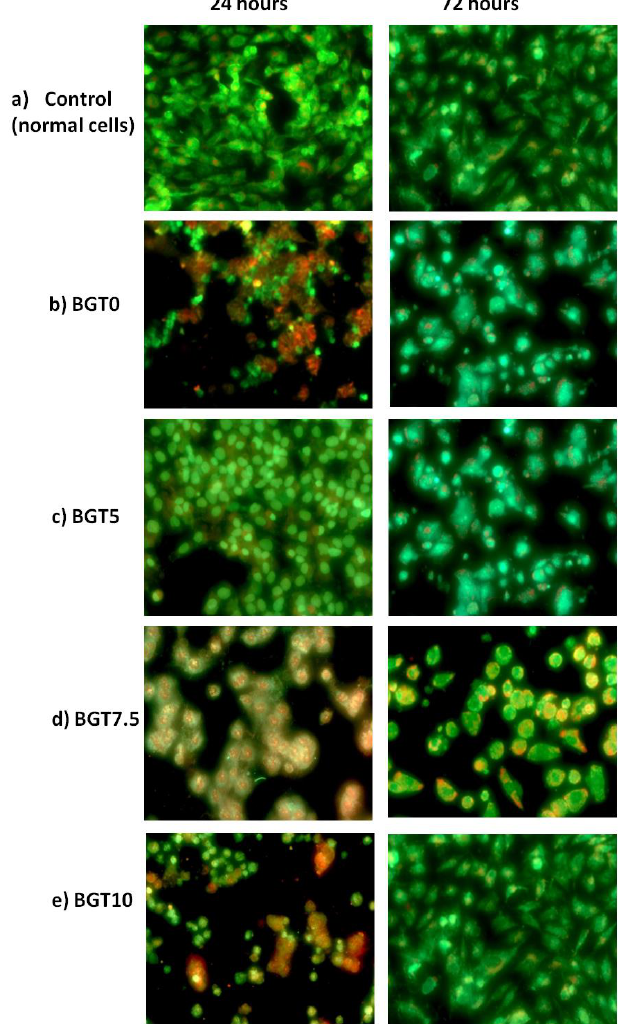
Figure 11. Images (magnification = 20×) were recorded using a fluorescence camera after 24 and 72 h exposure of MG63 cells to different glass types. ( a ) control, ( b ) BGT0, ( c ) BGT5, ( d ) BGT7.5 and ( e ) BGT10.